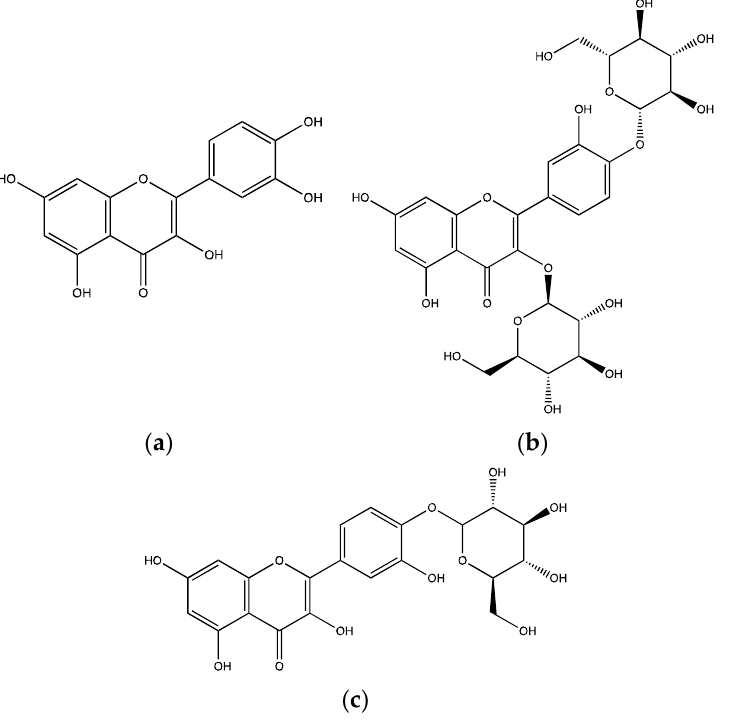
Figure 1. Chemical structures of quercetin ( a ) , quercetin-3,4′- O -diglucoside ( b ) and quercetin-4′- O - monoglucoside ( c ) isolated from Allium cepa .